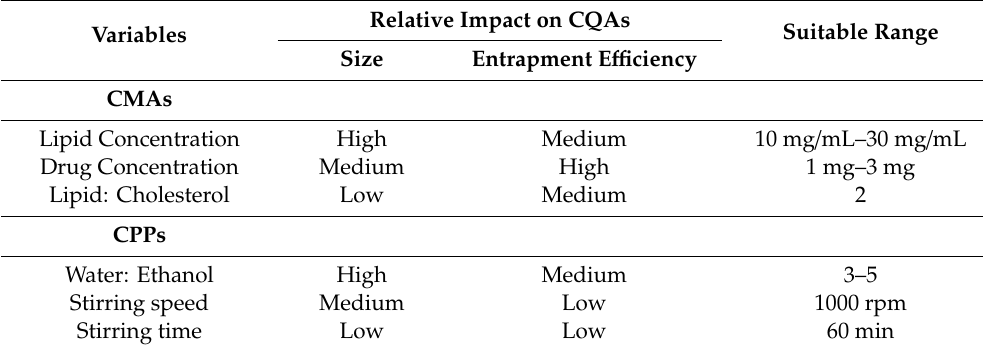
Table 1. Initial Risk Assessment (First